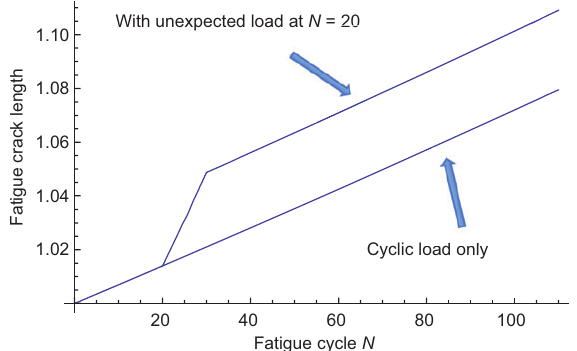
Figure 4 Fatigue crack length as a function of number of fatigue cycles for two stress cases, one with only cycling load and one with cycling load plus an unexpected load commencing at load cycle number 20 and lasting for 10 cycles.